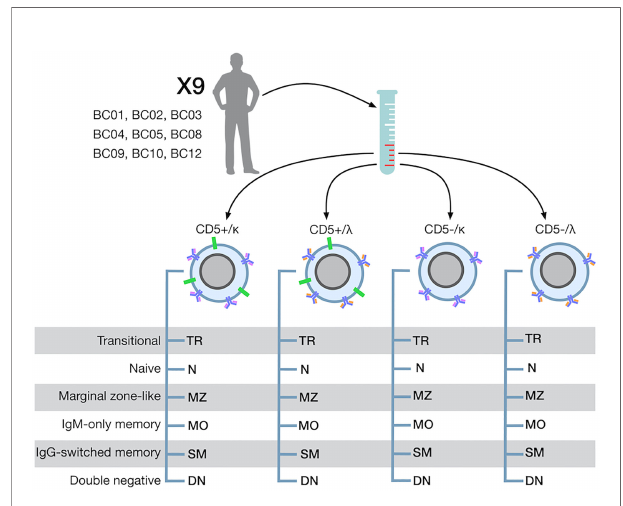
FIGURE 1 | B-cell separation